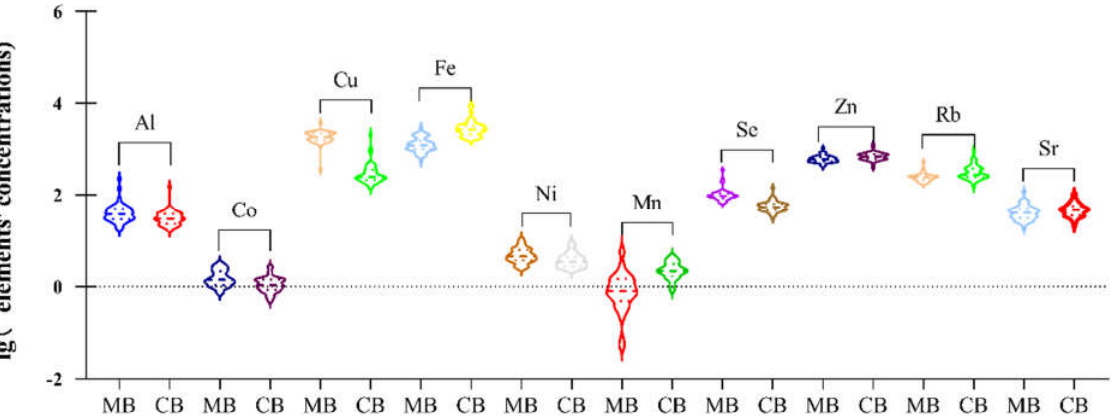
Figure 2. Violin plot of toxic and essential elements in maternal plasma at 3rd trimester and paired cord plasma. The plot was established based on the significant difference calculated by the Wilcoxon signed-rank Test ( p < 0.05) among plasma elements Al, Co, Cu, Fe, Ni, Mn, Se, Zn, Rb, and Sr. MB means maternal blood and CB refers to cord blood.